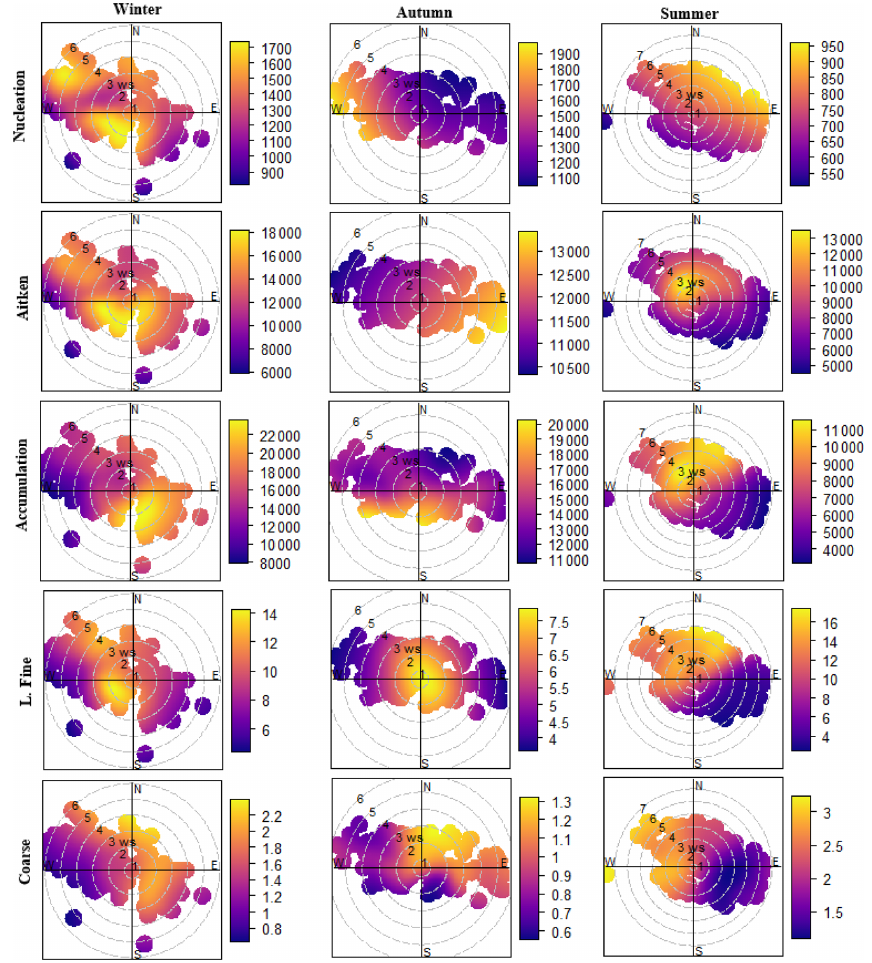
Figure 11. Polar plots of PNs (number per cm 3 ) for five particle size fractions in winter, autumn, and summer in